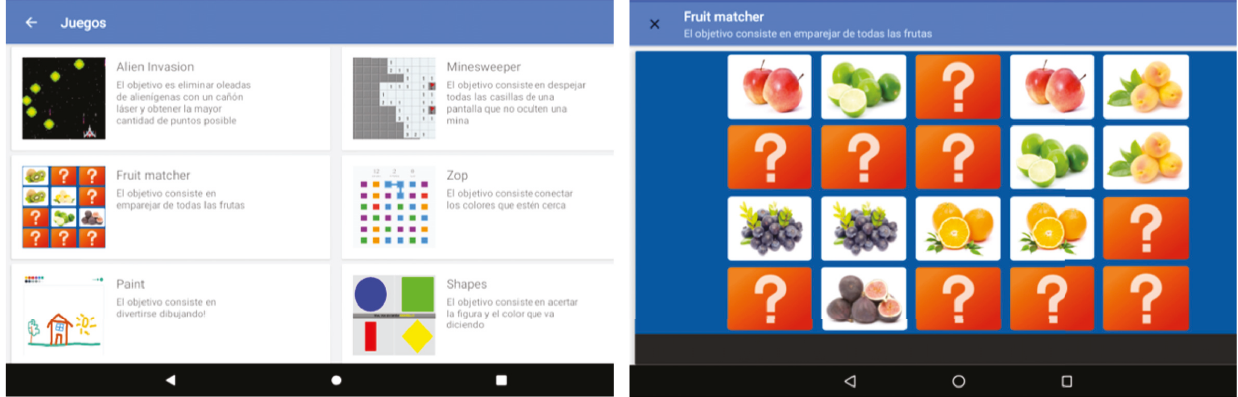
Figure 27: Minigame menu and example.